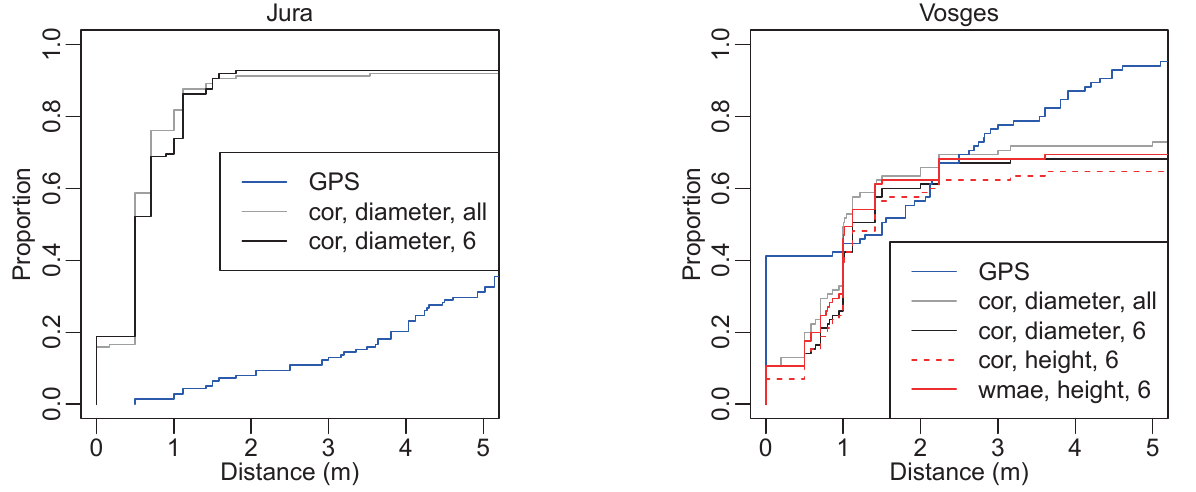
Cumulative proportion of validated plots as a function of the distance in meters between the operator position and the Global Navigation Satellite System (GNSS) position or the algorithm position depending on the method used ( cor correlation or wmae weighted mean absolute error), the input tree variable (diameter or height) and the number of considered trees (six or all). The curves are cropped to the distance interval 0–5 m.